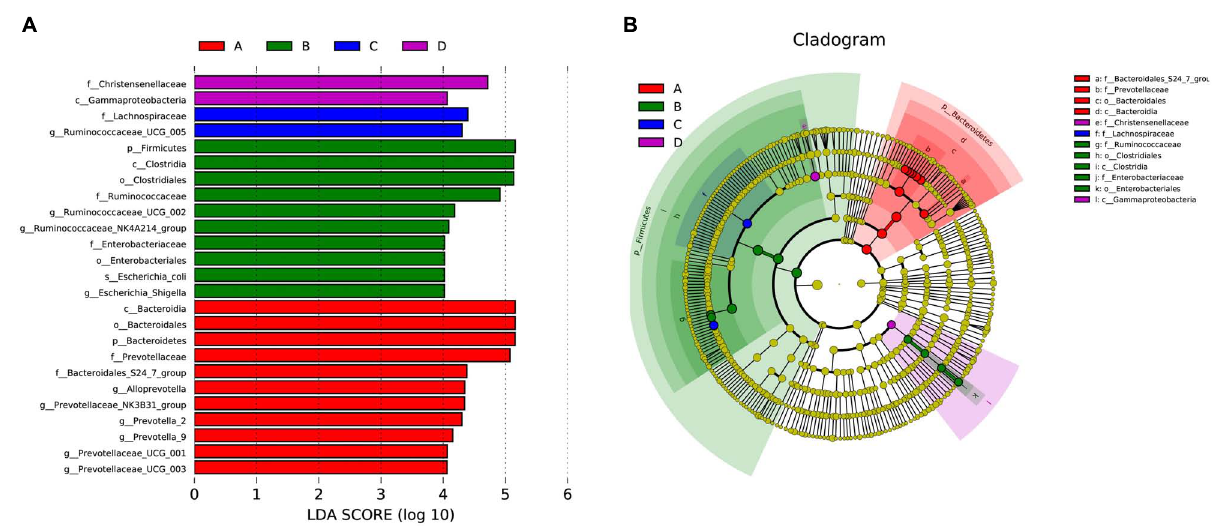
FIGURE 4 | LEfSe analysis of gut microbial composition in sows with different productive capacities during perinatal period; (A) Histogram of the LDA scores, showing the biomarker taxa (LDA score > 4). (B) Cladogram obtained from LEfSe analysis, indicating the phylogenetic distribution of microbiota. n = 6. A, C: sows with high productive capacity (HPC) at late pregnancy (LP) and early stage after parturition (EAP) separately; B, D: sows with low productive capacity (LPC) at late pregnancy (LP) and early stage after parturition (EAP)